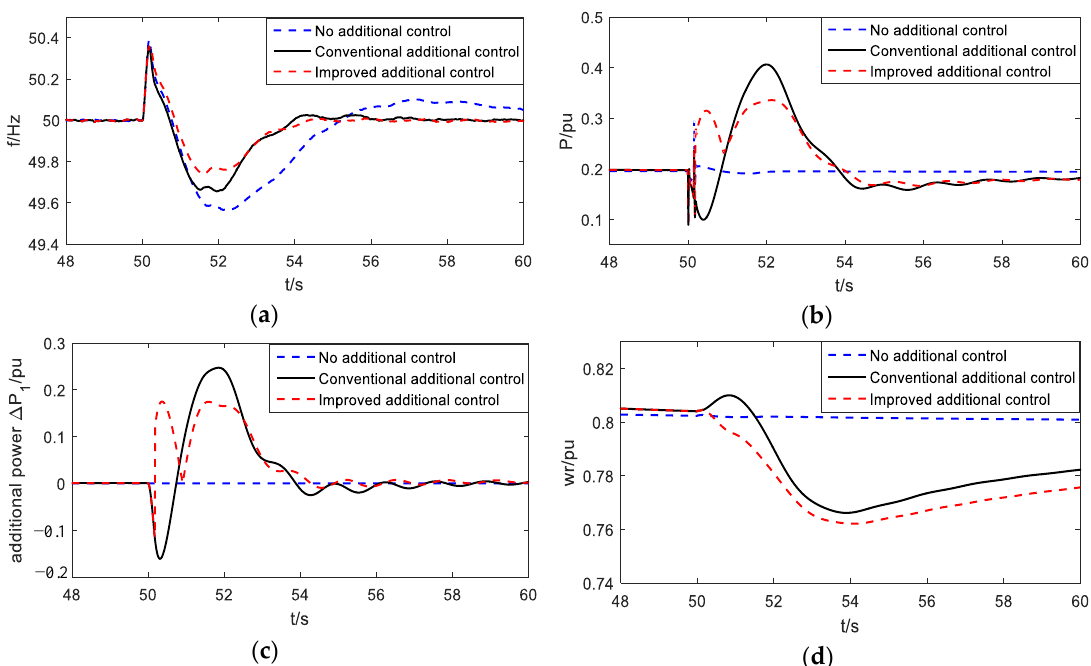
Figure 10. Change of parameters under a short-circuit fault by three different control methods in the wind speed of 8 m/s ( a ) System frequency; ( b ) Output active power of DFIGs; ( c ) Additional power of DFIGs; ( d ) Rotational speed of DFIGs.